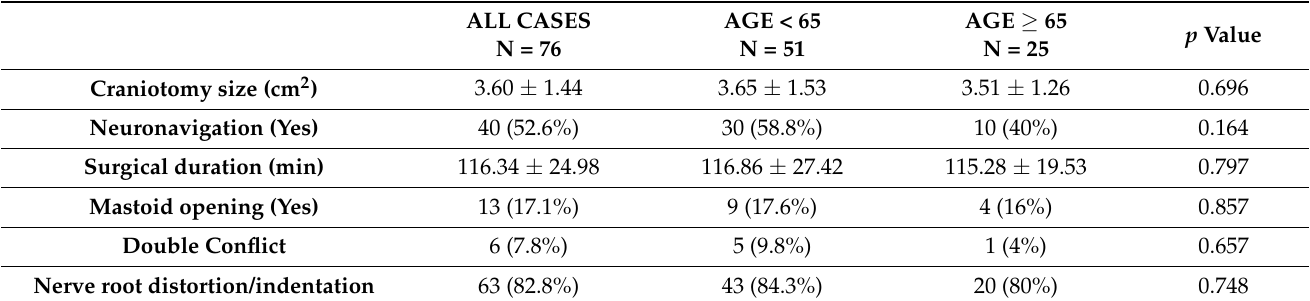
Table 2. Intraoperative data